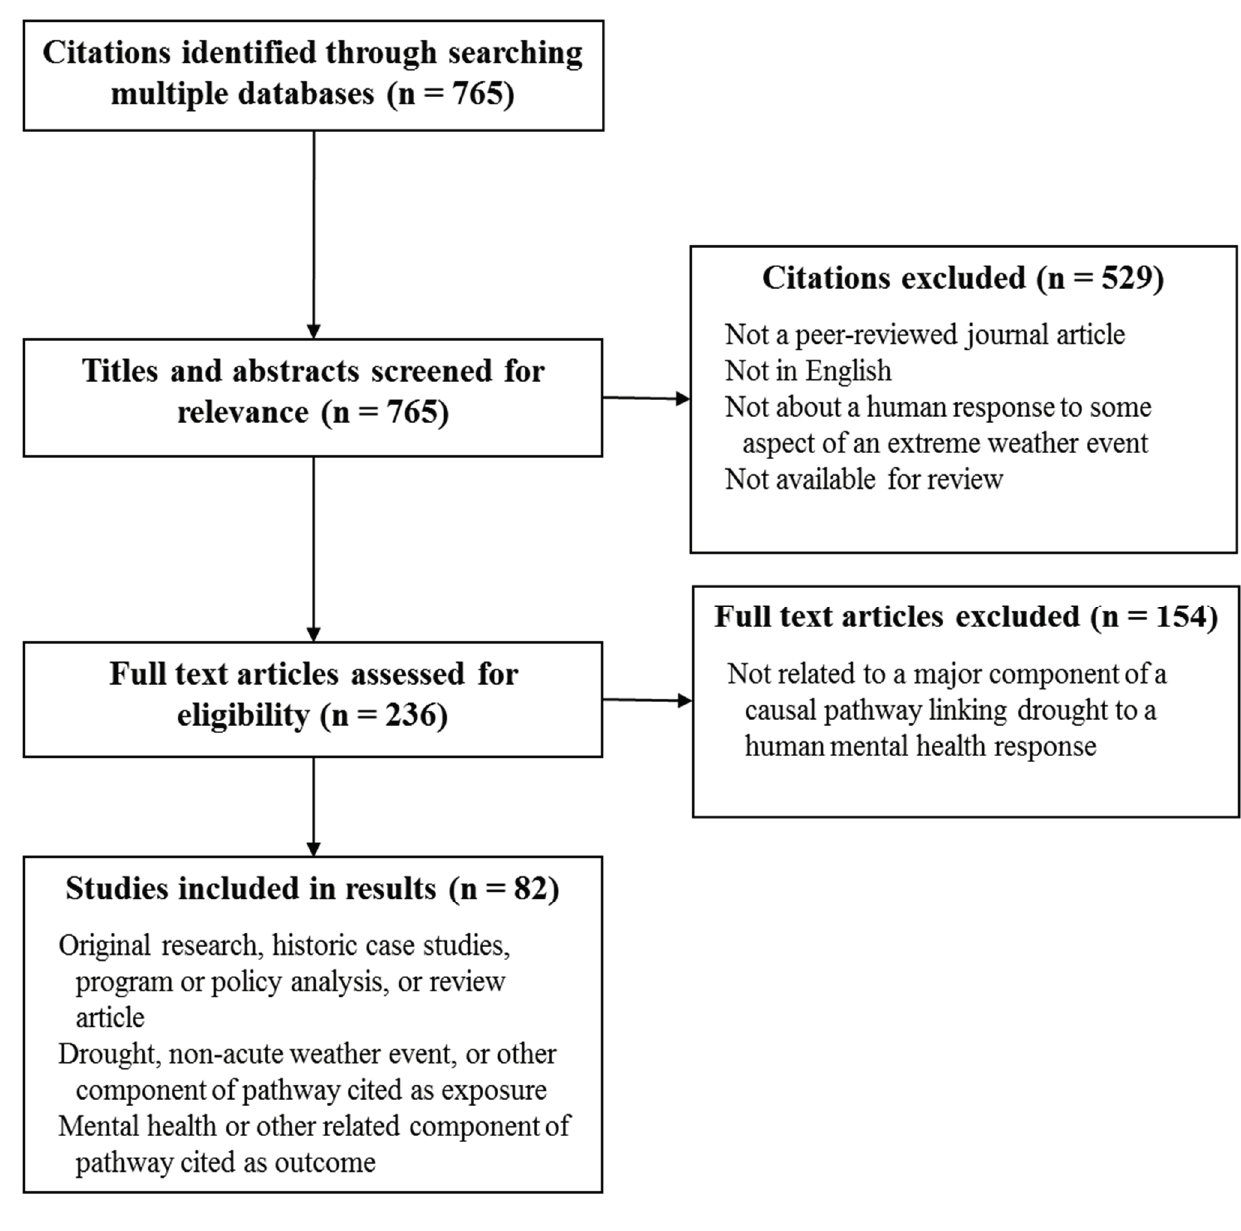
Figure 1. Flow chart of article inclusion and